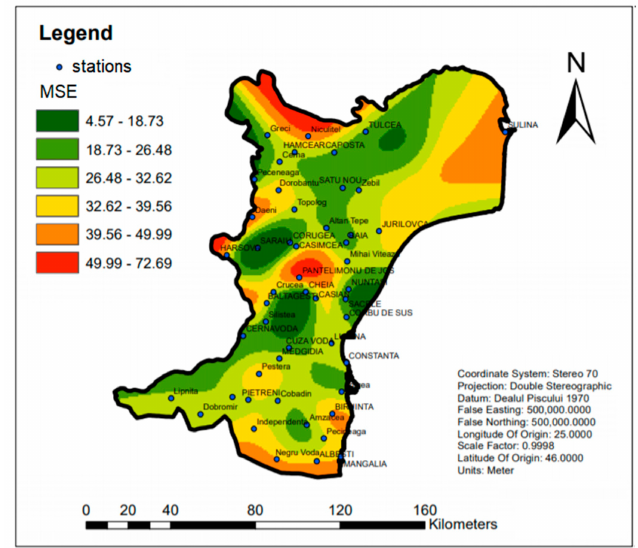
Figure 7. MSE in OIDW (scenario